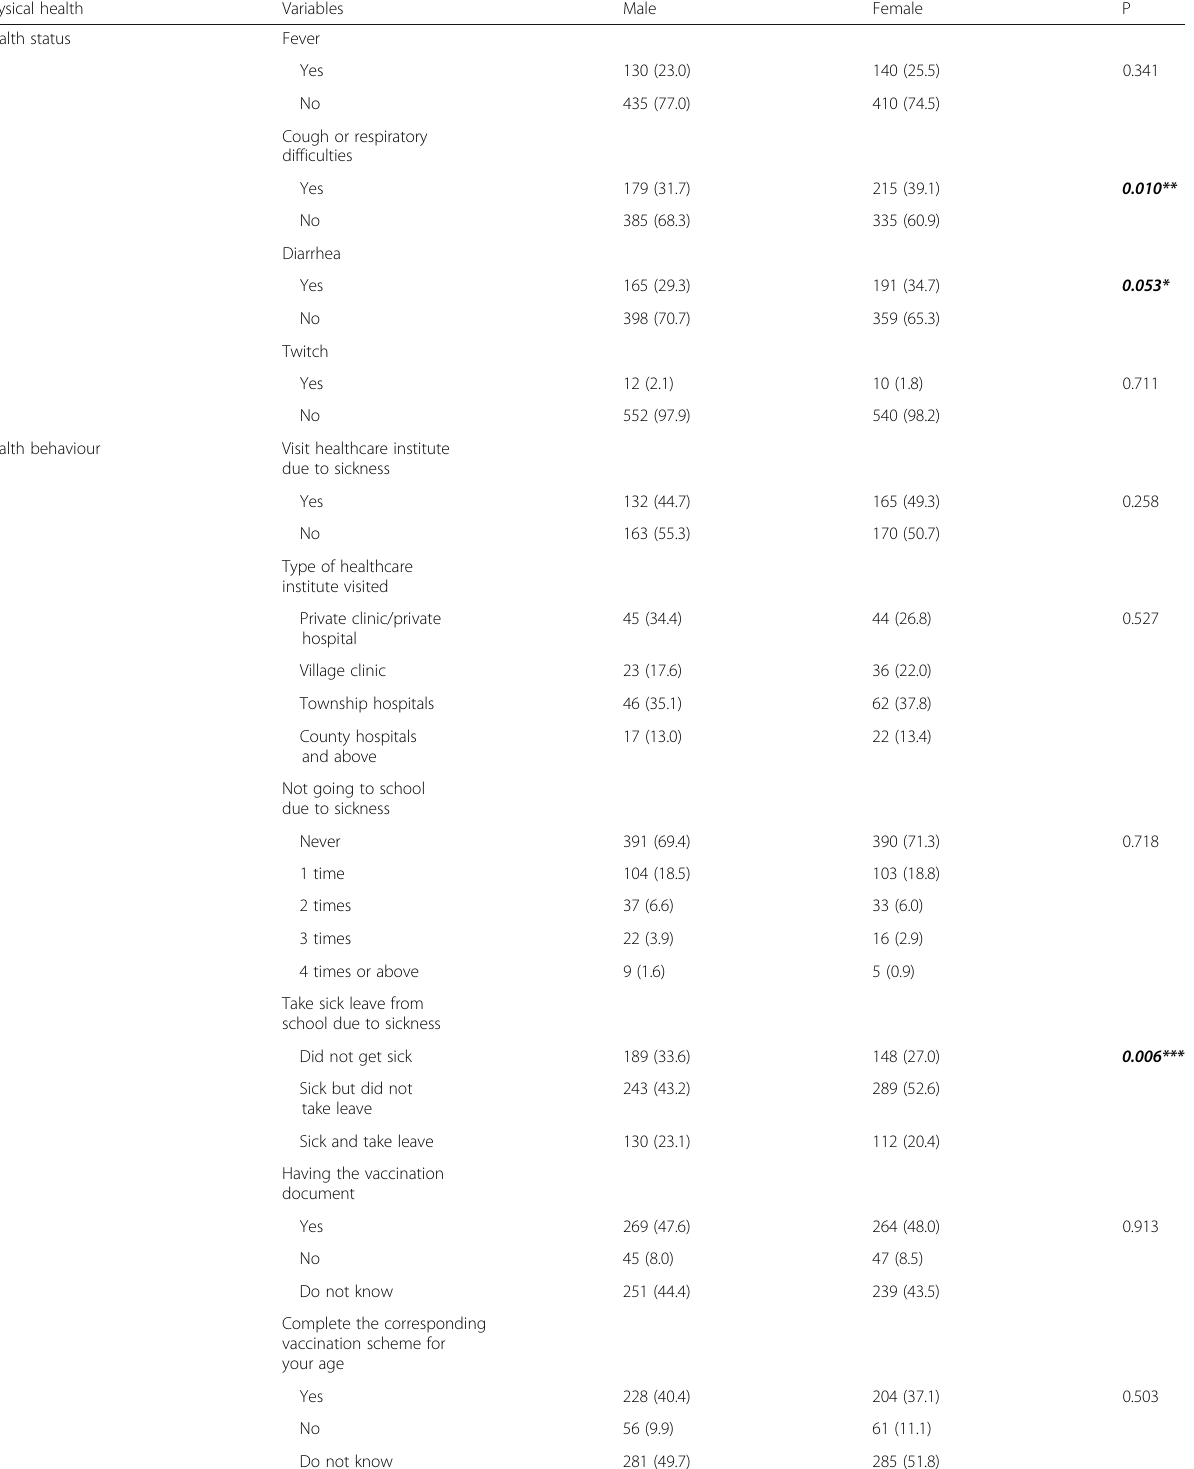
Table 3 Physical Health Variables between male and female among left-behind children Physical